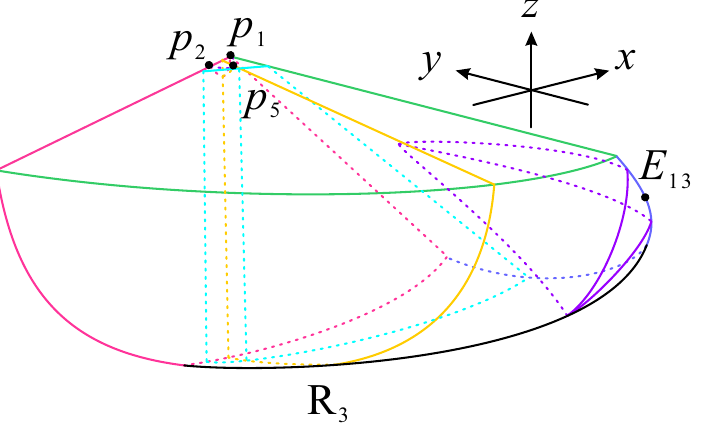
Figure 6. The purple surface is b 1 = 0, the yellow plane is b 2 = 0, and the light blue plane is b 3 = 0.